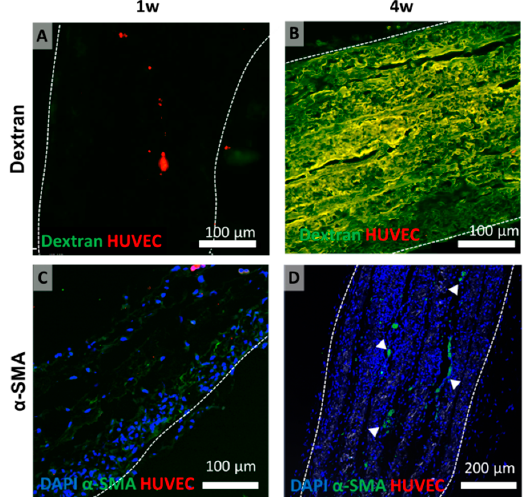
Figure 8. ( A , B ) Fluorescent images showing differences in Fluorescein isothiocyanate (FITC)-dextran perfusion, indicating connection between host and implanted sheets (group 6× embossed) in vivo. Dashed lines indicate edge of transplanted embossed sheets. Green: FITC-dextran, red: HUVEC. ( C , D ) Immunofluorescence images showing α -SMA expression in cross-sections of group 6× embossed at one and four weeks. Green: α -SMA, red: HUVEC, blue: DAPI. Arrowheads indicate α -SMA expression.